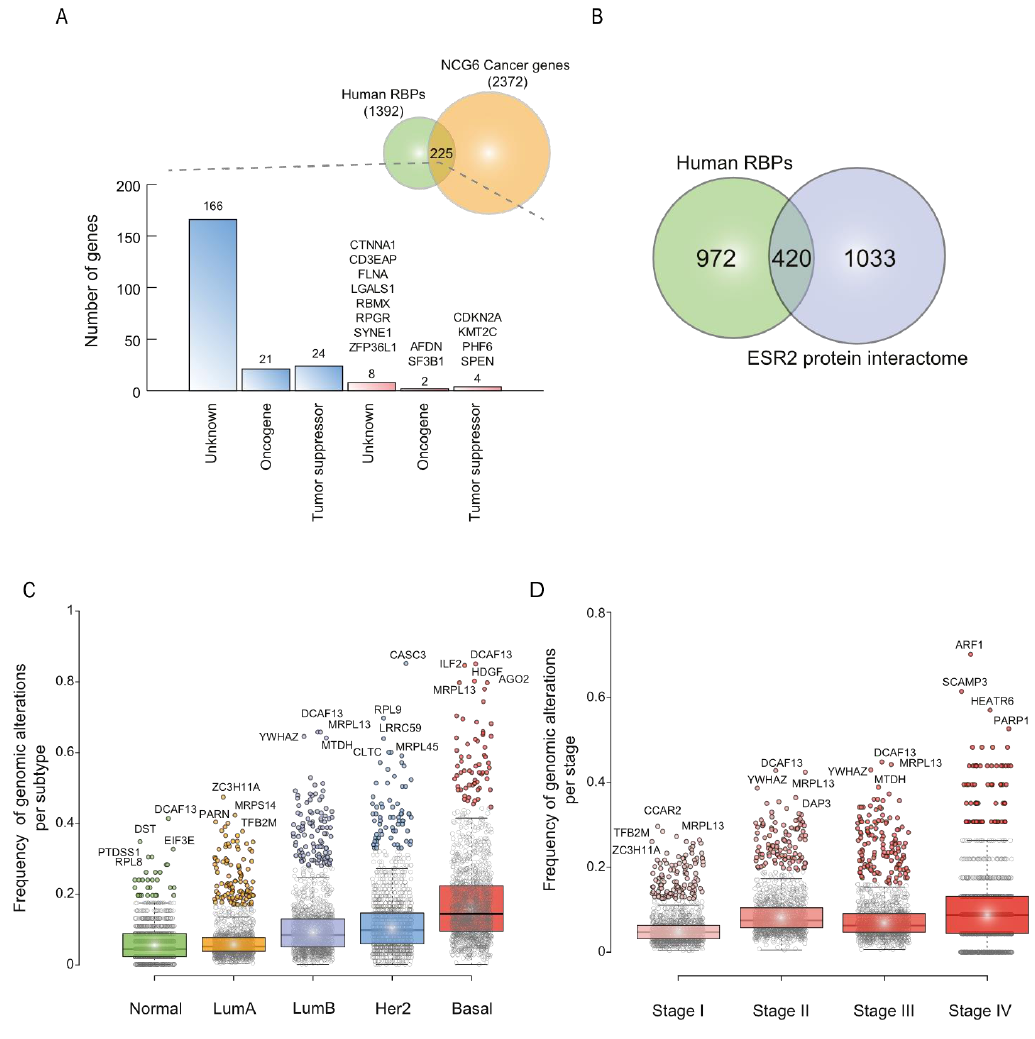
Figure 3. Identification of highly altered breast cancer RNA-binding proteins. ( A ) A histogram describing the status of RBPs in the Network of Cancer Genes 6.0 (NCG6). In blue, RBP status in other cancer types; in red, breast cancer RBPs. ( B ) A Venn diagram depicting the relationship between RBPs and ESR2 protein interactomes. RBPs genomic alterations per subtype ( C ) and stage ( D ), using the Breast Invasive Carcinoma (TCGA, PanCancer Atlas) and Breast Cancer (CPTAC) [5–10,35] database, are displayed. Genomic alterations per subtype and per stage were corrected by the number of patients; a Mann–Whitney U test was used to compare genomic alterations between sets. All possible comparisons between sets present significant differences ( p < 0.001) except Normal vs. Lum A subtypes; ns = not